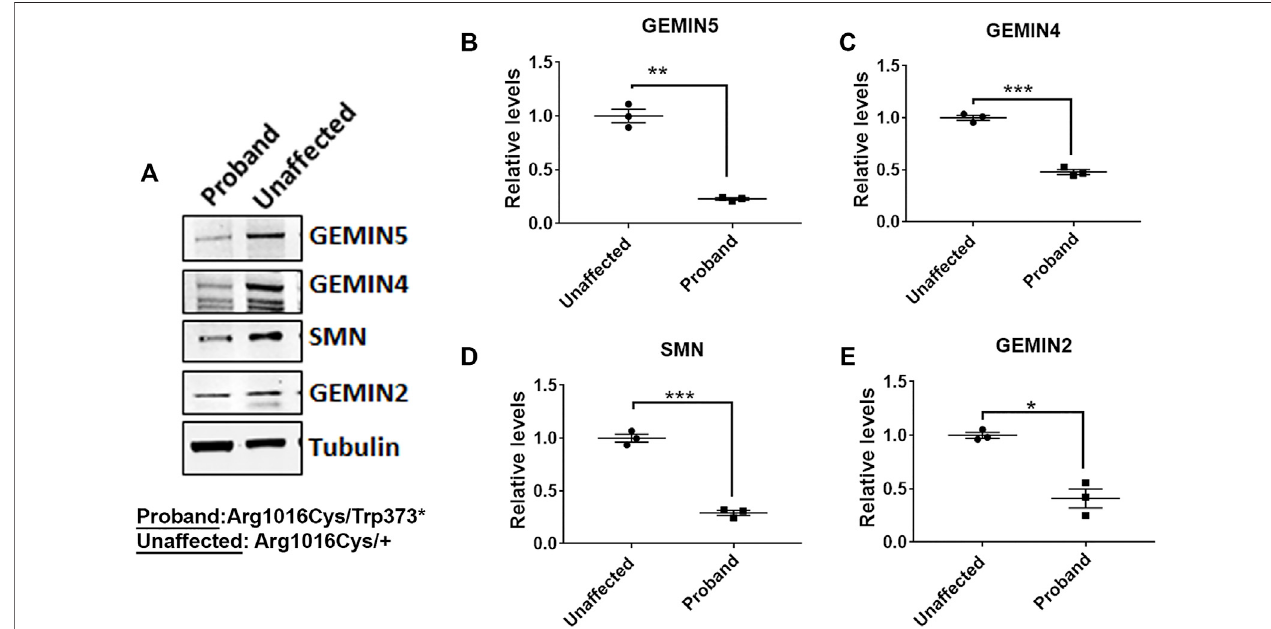
FIGURE 3 | Individual with compound heterozygous variants in GEMIN5 demonstrates reduced levels of SMN complex proteins. (A) Representative immunoblot showing the protein levels of SMN, GEMIN4, and GEMIN2 in the patient carrying p.Trp373* and p.Arg1016Cys variants in GEMIN5 . Protein lysates were prepared from the PBMCs isolated from the patient and the unaffected parent (Arg1016Cys/+). (B – E) Quantitative plot showing the reduced levels of GEMIN5 (B) , GEMIN4 (C) , SMN (D) , and GEMIN2 (E) proteins in the patient relative to unaffected parent (father). The data represent mean ± SEM. p -Values (*** < 0.001, ** < 0.01, * < 0.05) are calculated by unpaired t test ( n =